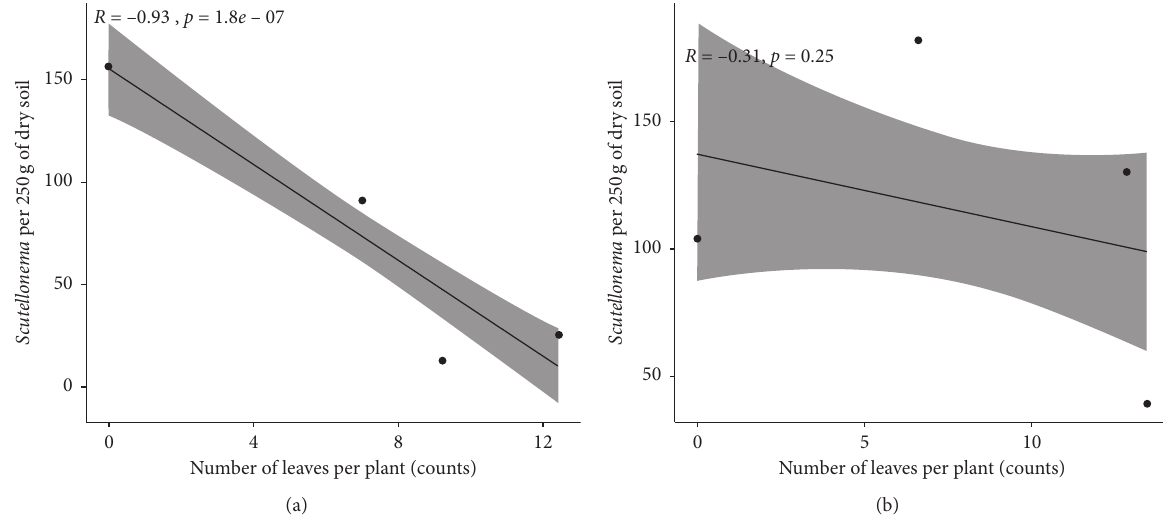
Figure 6: Correlation between number of leaves per plant and Scutellonema density during 2018 (a) and 2019 (b) in control plots. The relationship for 2018 showed a significant negative association ( R � − 0.93, p ≤ 0 . 001), while for 2019 it was nonsignificant ( R �− 0.31, p � 0 .